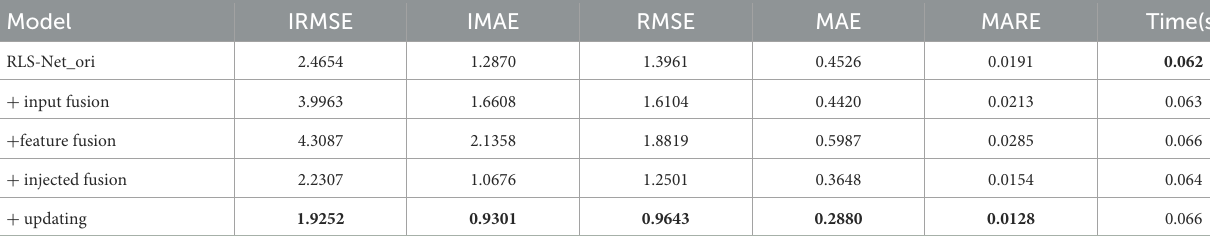
TABLE 4 Results of the injected guided initialization and updating module.